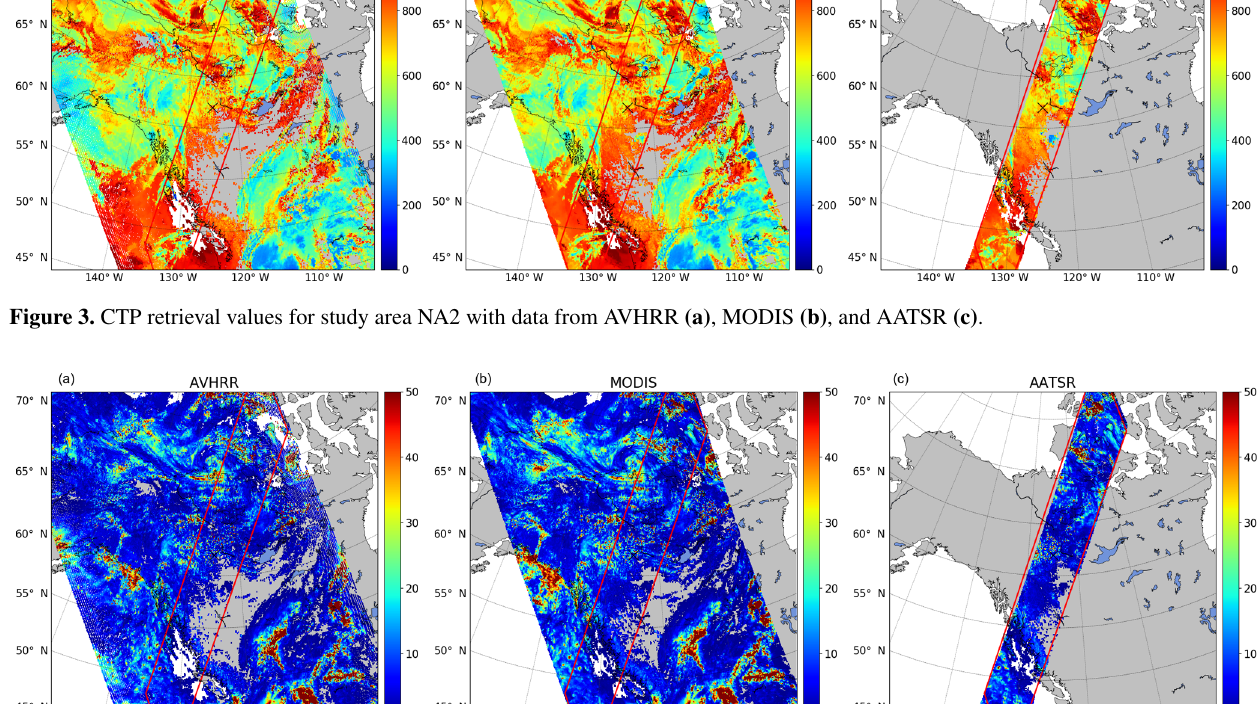
relative retrieval uncertainties (100 × uncertainty / retrieved value) are shown for CTP, COT, and CER.